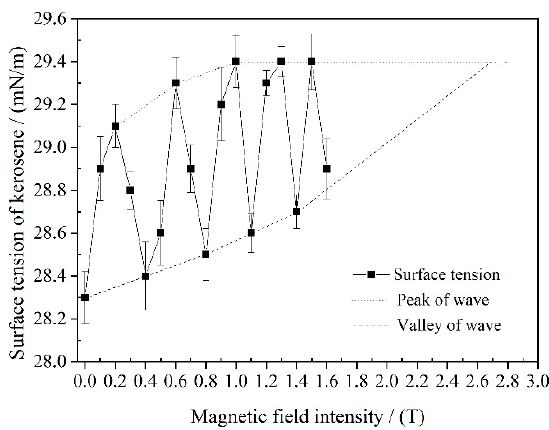
Figure 6. The influence of magnetic field intensity on the surface tension of kerosene (298 K).